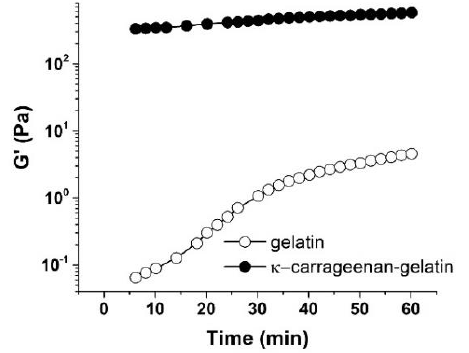
Figure 7. Time dependence of elastic modulus (G’) of gelatin (–) and κ -carrageenan–gelatin (,) hydrogels at 14 ◦ C and ω = 0.2 s − 1 , deformation amplitude γ = 0.2%.